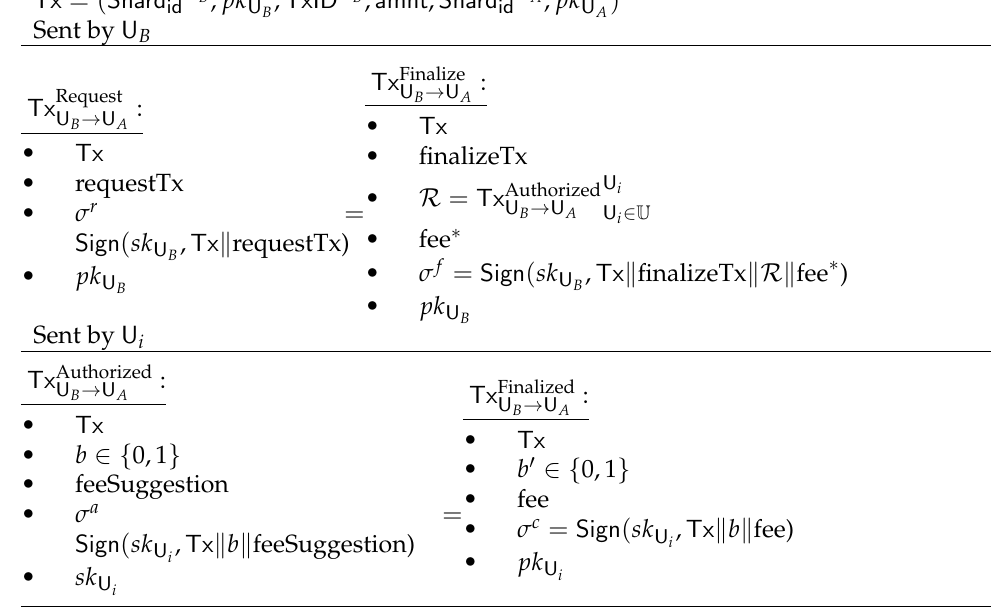
Figure 5. Dandelion transaction message description of senders and the network for a valid transac- tion Tx . We let the bit b = 0 denote denied, and b = 1 denote accepted, and fee is computed as the median of the lower two-thirds of